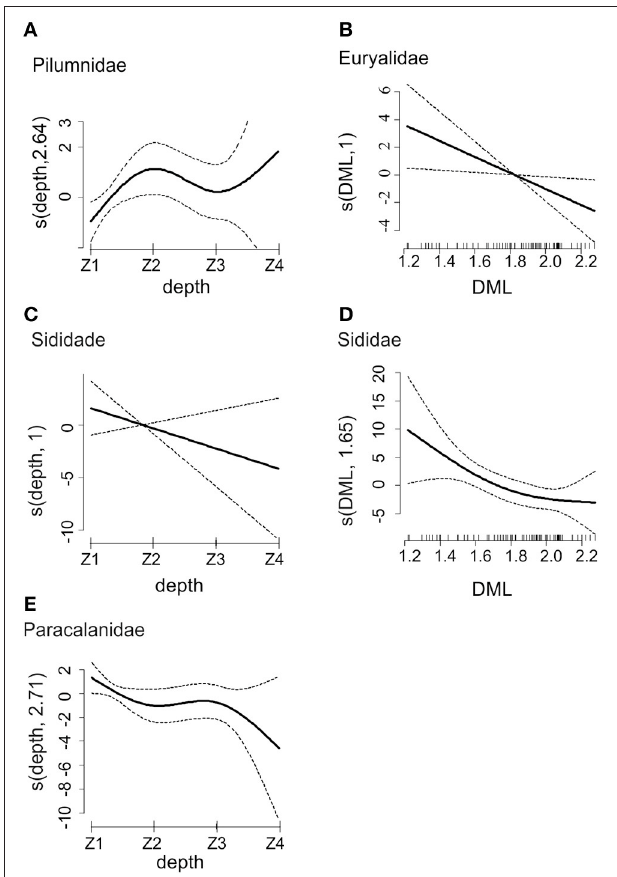
FIGURE 7 | Smooth curves for partial effects obtained by the Generalized Additive Modeling (GAM) of the occurrence of the families Pilumnidae (A), Euryalidae (B) , Sididae (C,D) , and Paracalanidae (E) as prey of O. vulgaris paralarvae. Explanatory variables used were dorsal mantle length (DML) and depth (Z1, Z2, Z3, Z4). Dotted lines are 95% confidence bands. The vertical axis represents the effect on the response